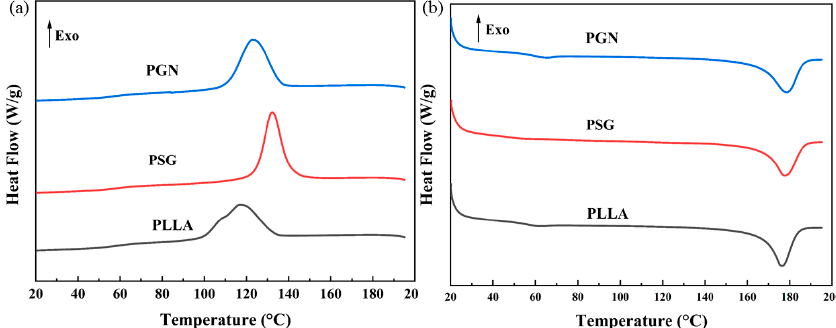
Figure 4. DSC curves of ( a ) the cooling curves and ( b ) the heating curves of PLLA, PSG and PGN nanocomposites with different filler contents. Table 1. Calorimetric data derived from the DSC cooling curves and heating curves for the PLLA, PSG and PGN nanocomposites.